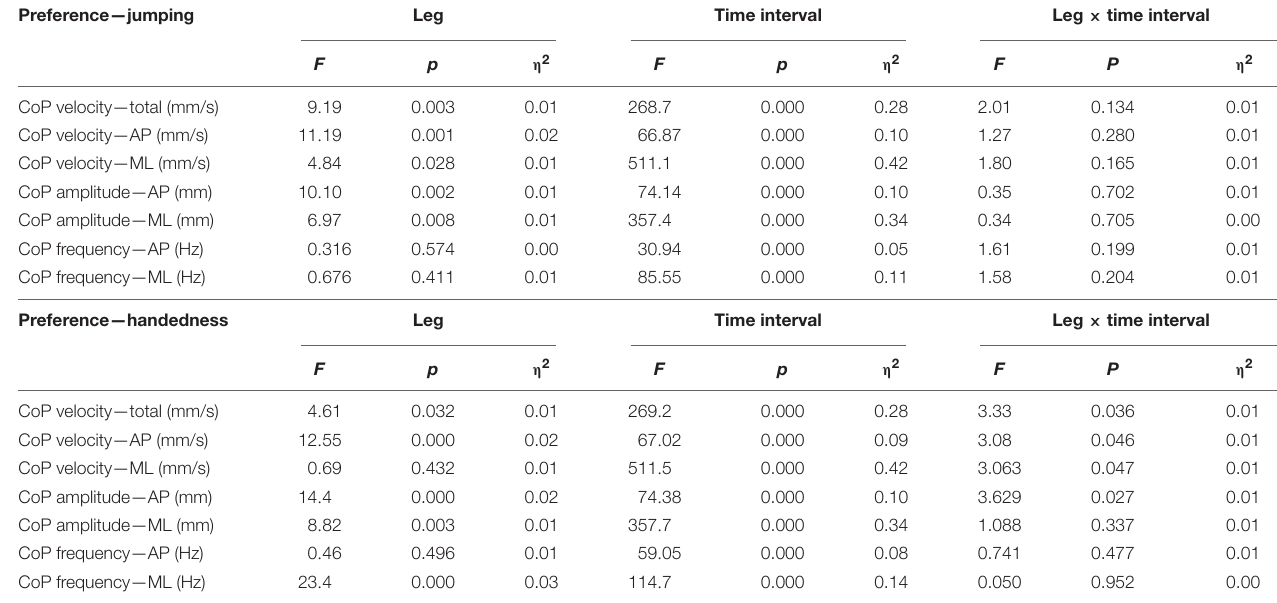
TABLE 2 | Two-way analysis for variance for effects of leg and time interval on body sway outcome variables.